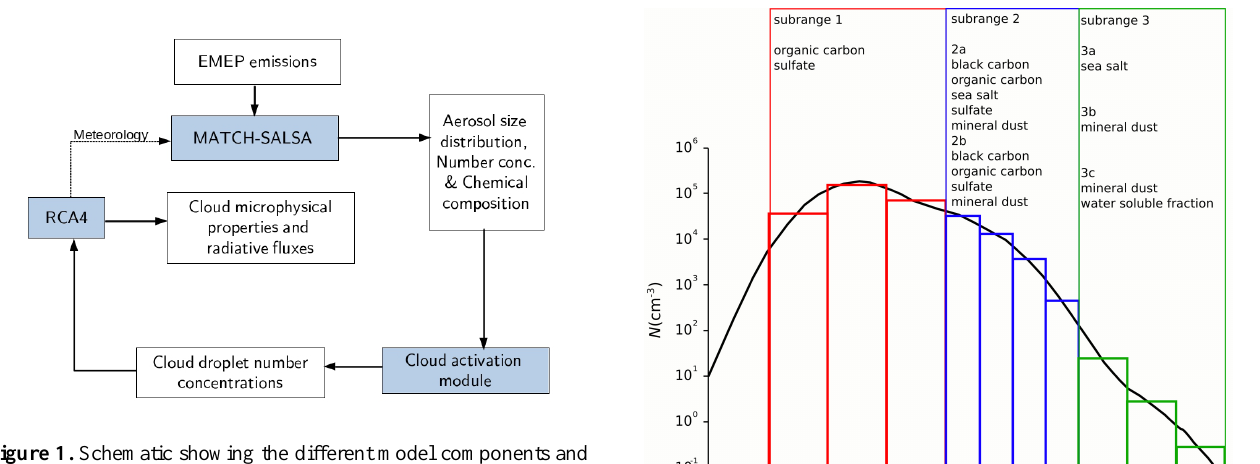
Figure 1. Schematic showing the different model components and their couplings.